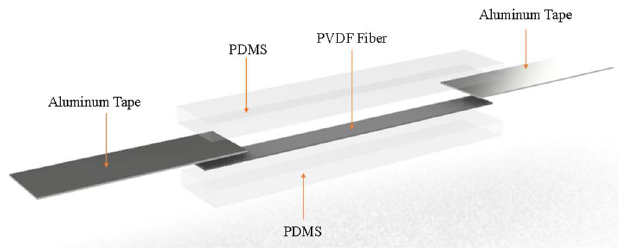
Figure 1. Structure of self-powered strain sensor.